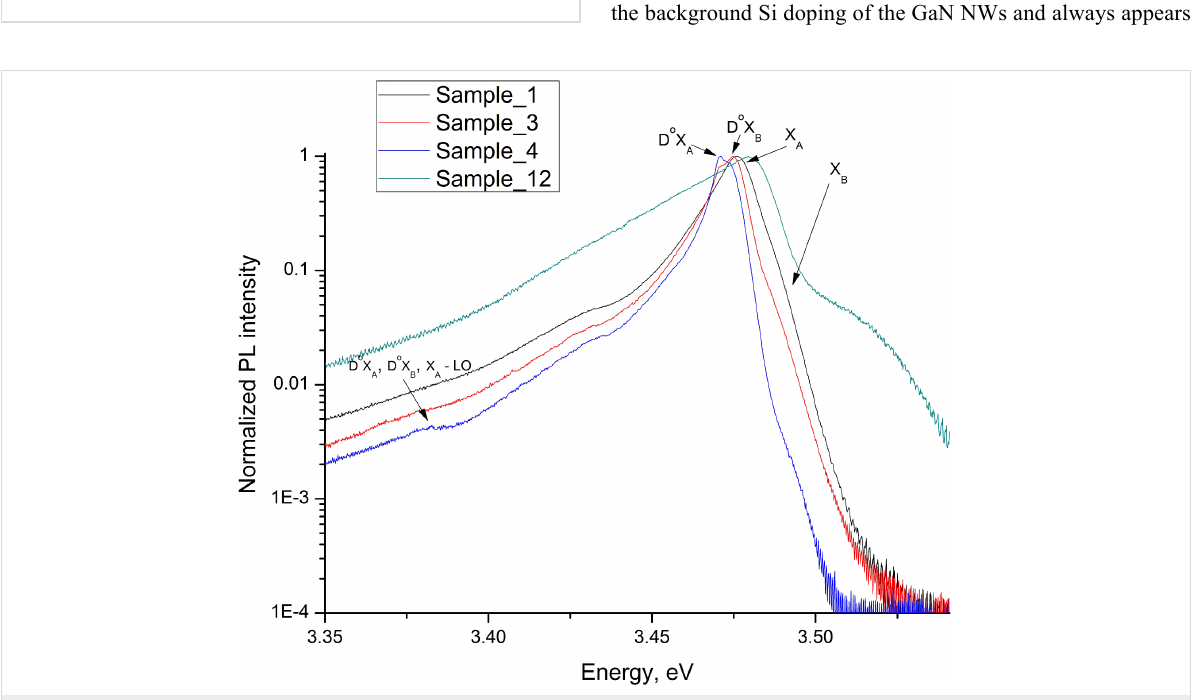
Figure 3: Photoluminescence (PL) spectra of the synthesized GaN nanostructures.